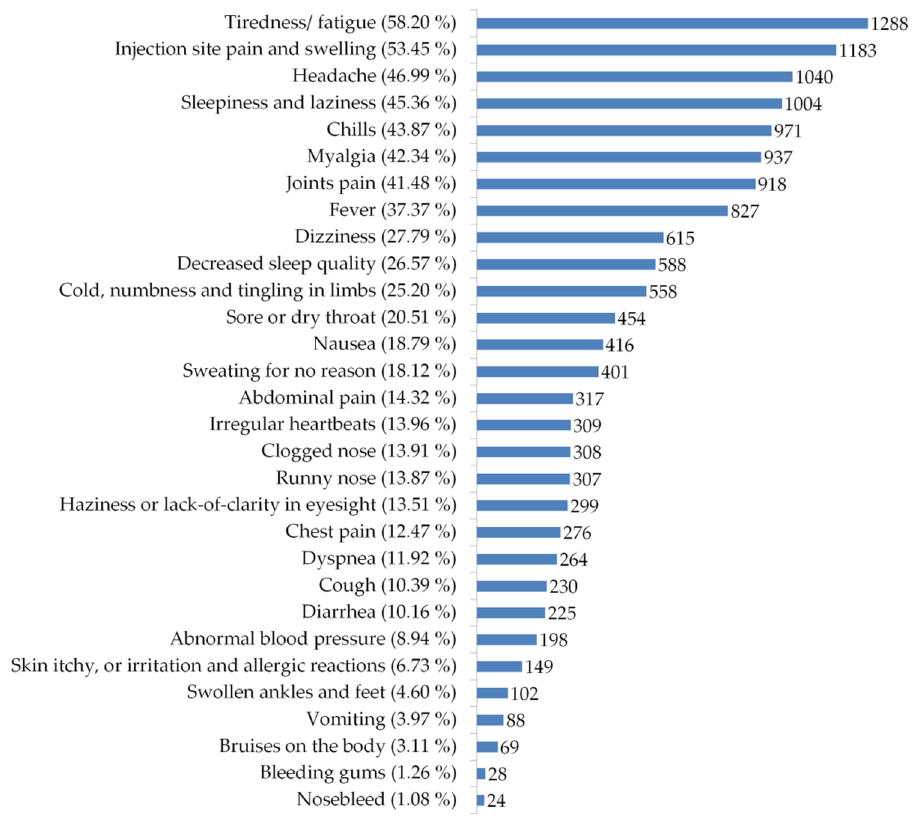
Figure 6. Frequencies of side effects that appeared after receiving COVID-19 vaccines.